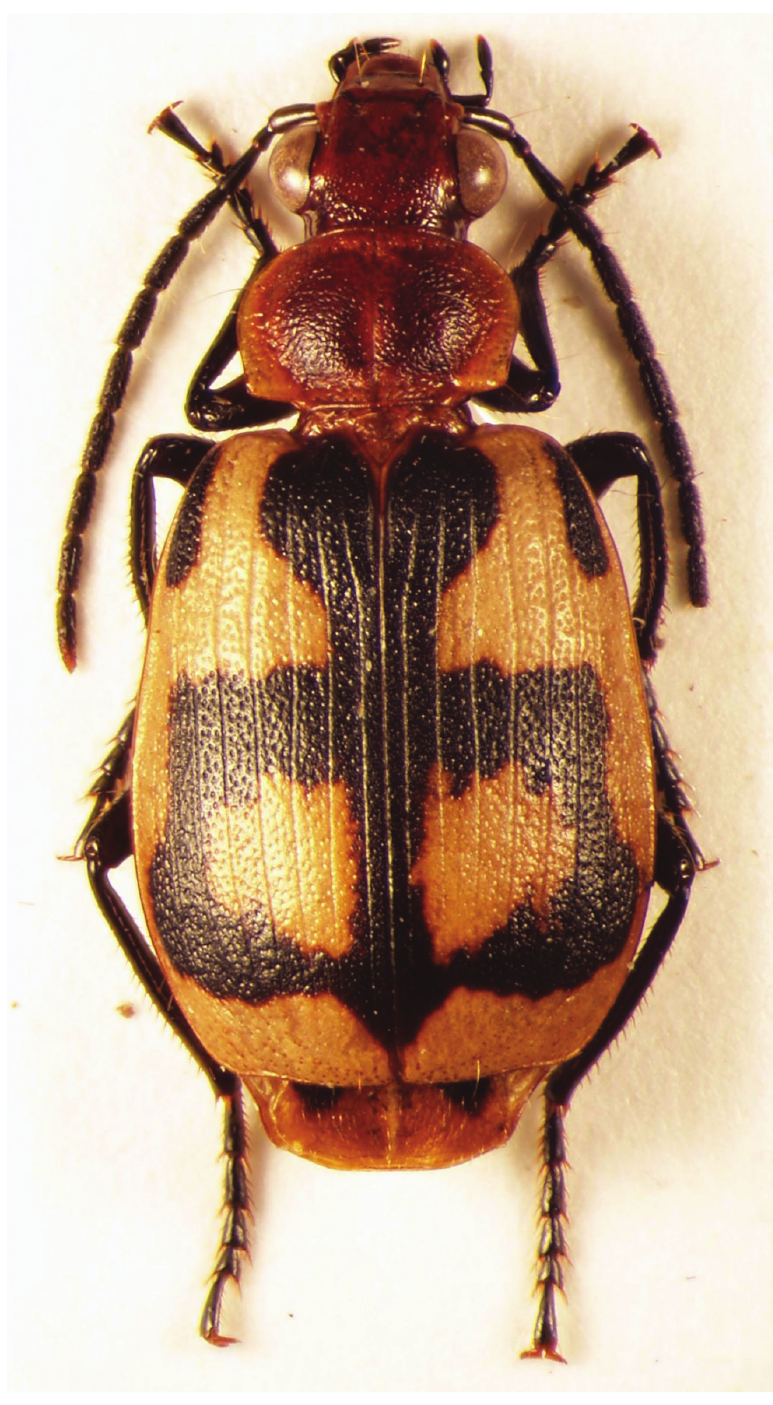
Figure 6. Lebistina petersae sp. n., habitus